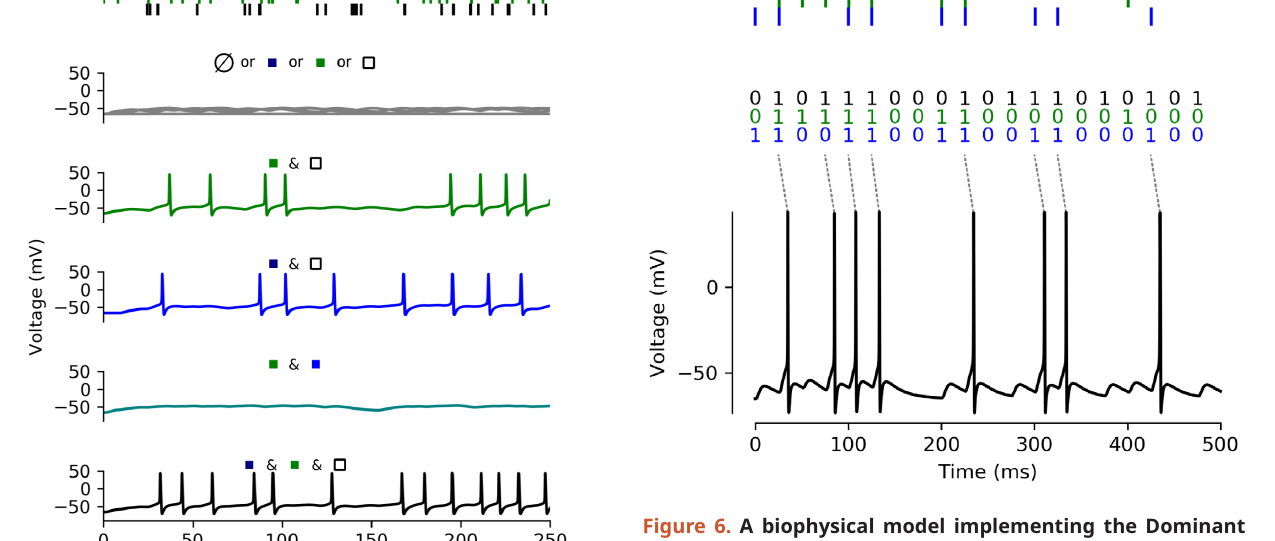
Figure 6. A biophysical model implementing the Dominant AND (spike interpretation). Top: The biophysical model receives input from three sources, where activation happens at regular intervals of 25 ms, with a random jitter of ±1ms for each spike. We translate this activity into a binary pattern for each time bin of 25 ms. Bottom: The model’s membrane potential as measured in the soma. The response spikes implement the output of the D-AND computation as described in Table 2